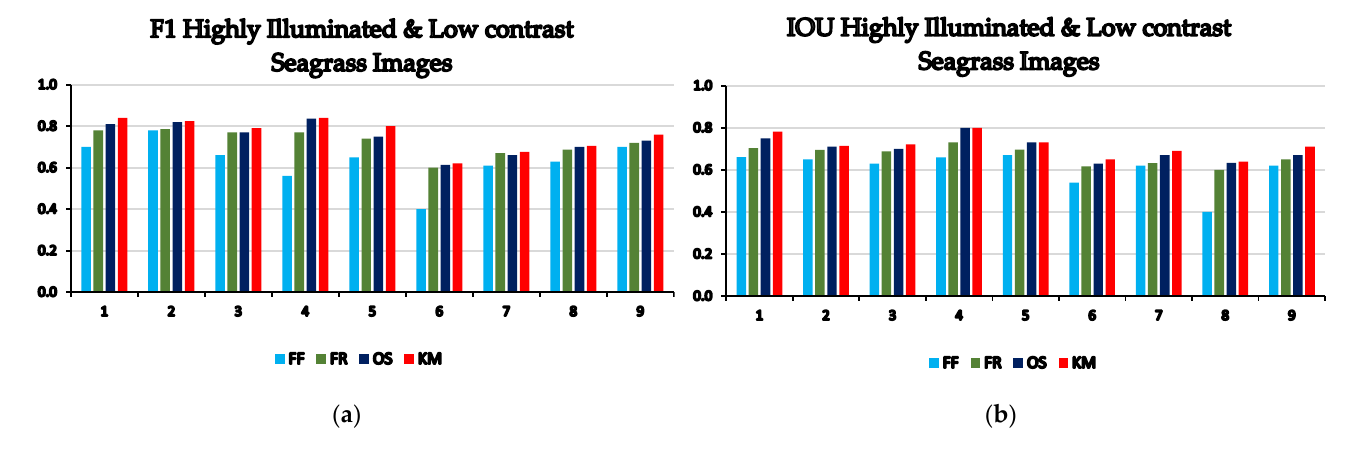
Figure 27. The results of evaluating the tested segmentation algorithms using highly illuminated and low contrast seagrass images. Images (1 – 5) had two categories, and (6 – 9) had three categories: